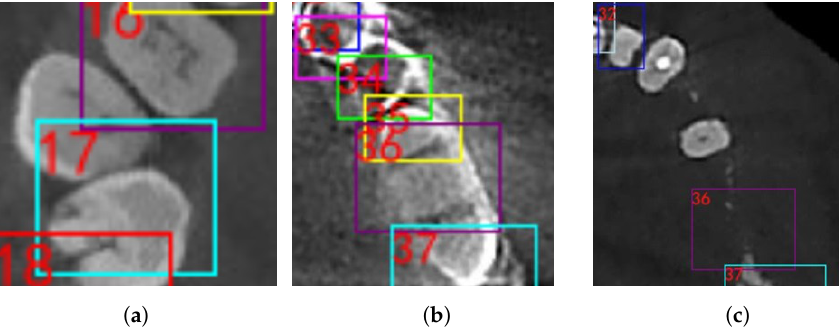
Figure 7. Typical situations of error occur in the detection process. ( a ) Severe malocclusion; ( b ) ex- treme metal artefacts; ( c ) continuous missing